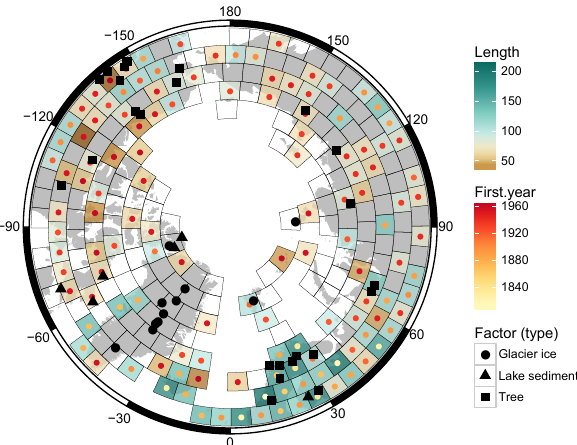
Figure 1. Distribution of input data. Length (fill of quadrilaterals) and first year (coloured circles) of the regridded instrumental data. Symbols show the locations and type of proxy data used (PAGES 2k Consortium, 2017). The reconstruction target area is all grid cells marked with wire